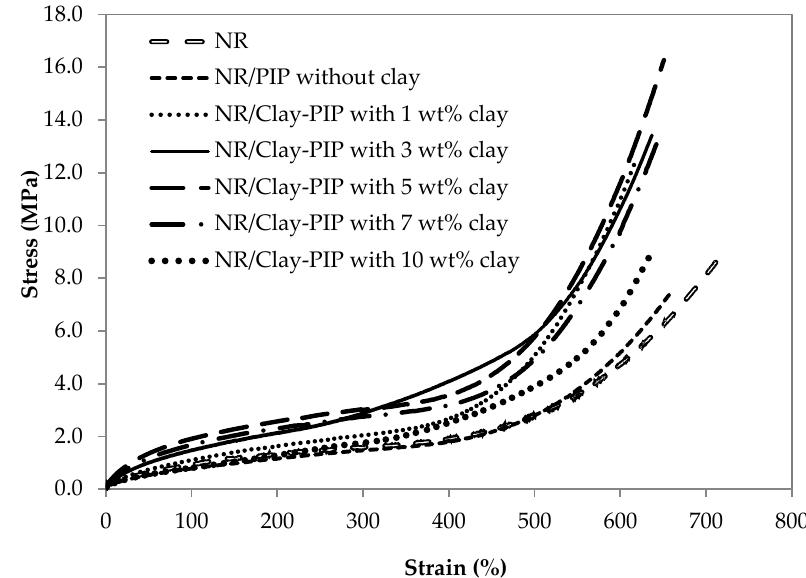
Figure 6. The effect of nanoclay content in the Clay-PIPs on stress – strain behavior of the NR thin films blended with the Clay-PIPs. Each curve was taken based on the median value among five test specimens. The clay contents are relative to the monomer amount.